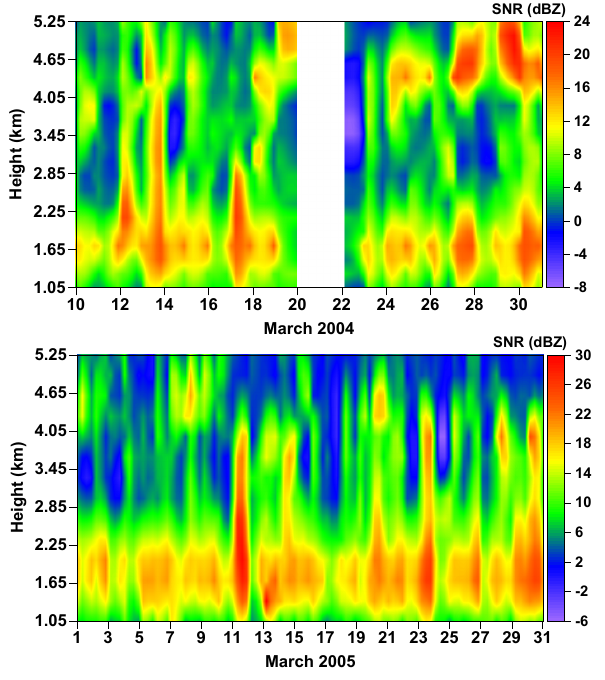
Figure 8 Fig. 8. Time-height cross sections of Wind Profiler-derived Signal- to-Noise Ratio (dBZ) in March 2004 (top panel) and in March 2005 (bottom panel).